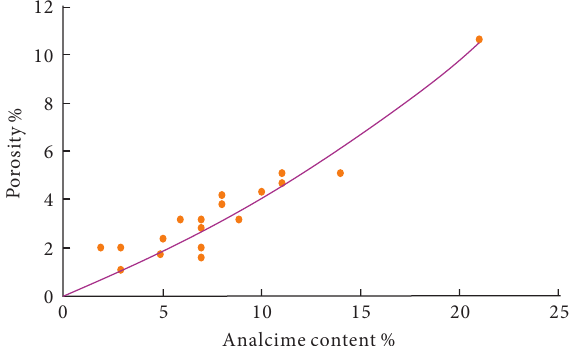
Figure 13: Relationship between analcime content and reservoir porosity [12,